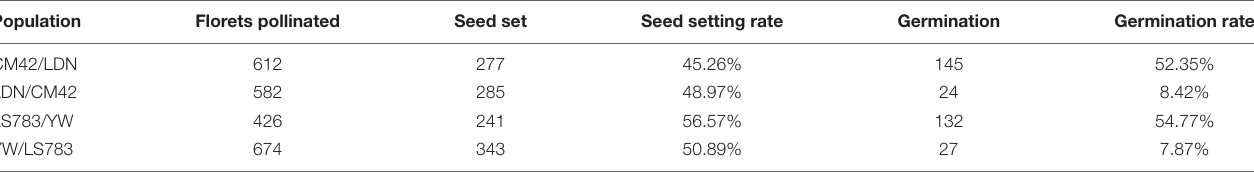
TABLE 1 | Statistical of seed setting rate and germination rate in reciprocal crosses.